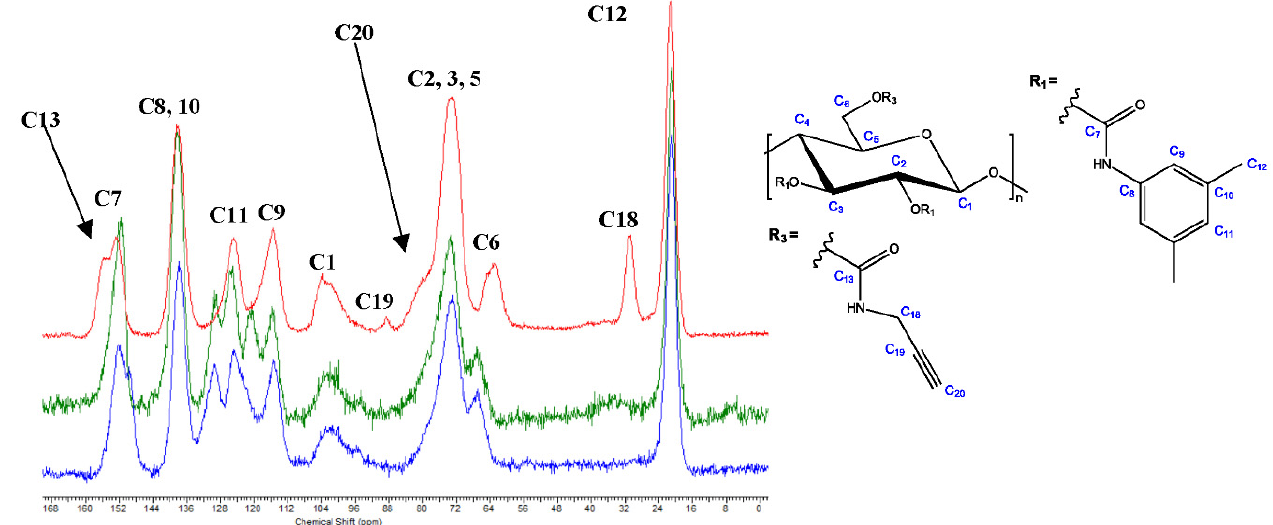
Figure 4. Solid-state 13 C NMR spectra of cellulose derivative 12 (red) vs. 11c (green) and 11b (blue).